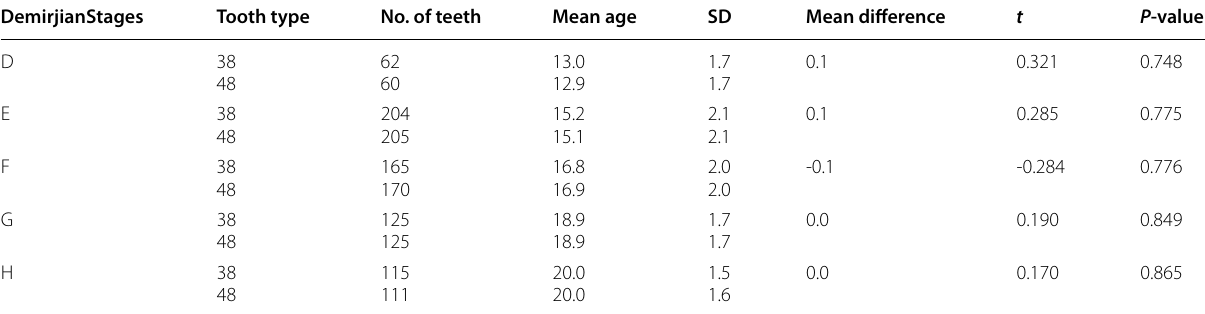
Table 3 Age distribution of participants with teeth at different stages of root development for right and left mandibular molars ( n 1342) =